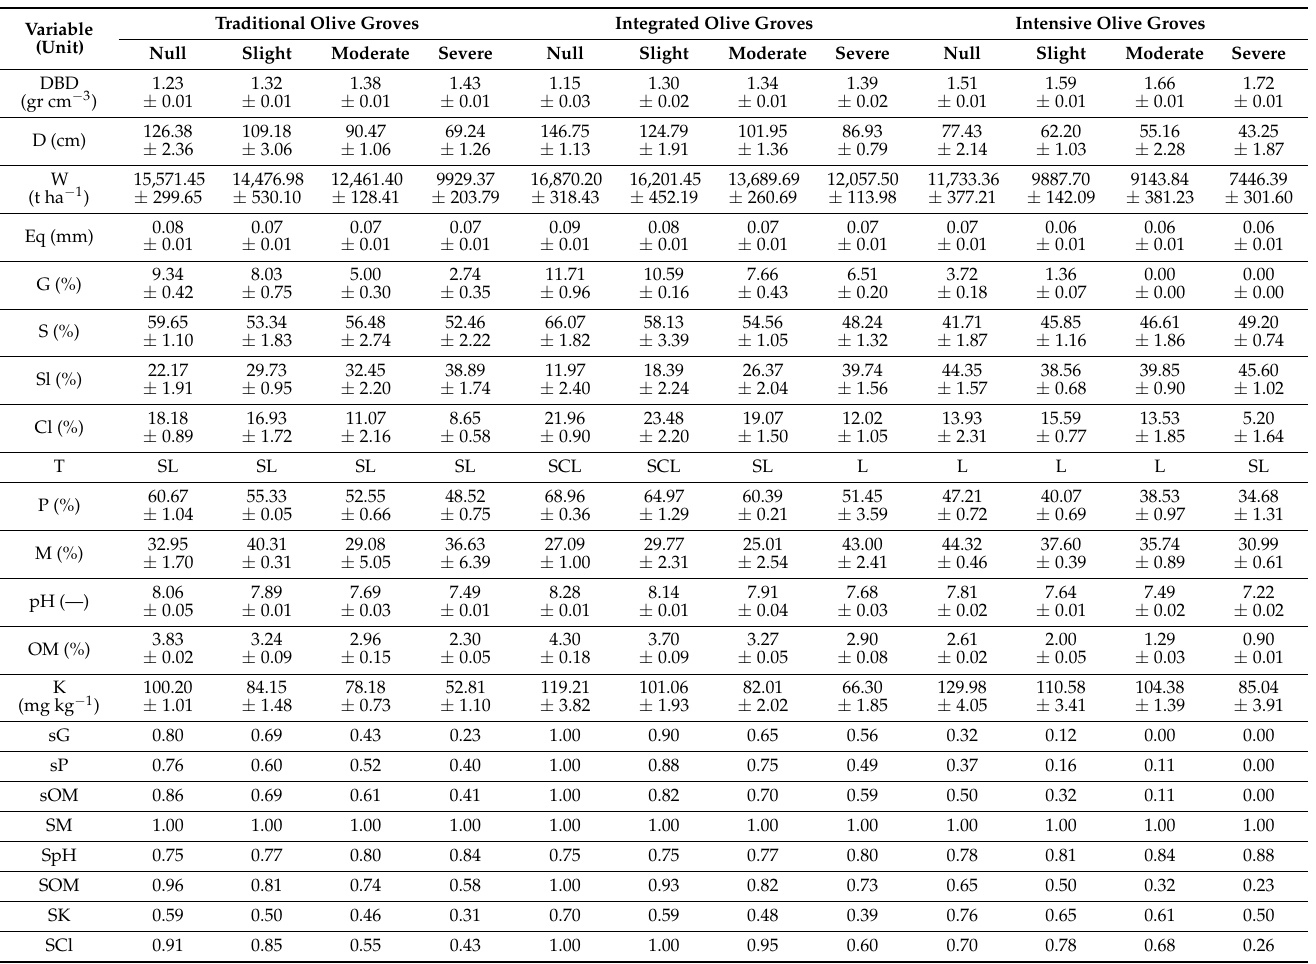
values of 20.03%, 25.39%, and 26.54%, respectively, for traditional, integrated, and intensive olive groves, with the latter presenting the lowest values. Table 3. Mean and standard error (x ± SE) values for each of the edaphic variables analysed (DBD: dry bulk density; D: soil depth; W: soil weight; Eq: equivalence 1 t soil; G: gravel; S: sands; Sl: silts; Cl: clays; T: texture, where L: loam, SL: sandy-loam, SCL: sandy-clay-loam; P: porosity; M: moisture; OM: organic matter; K: potassium). Their units are specified according to the different management options (i.e., traditional, integrated, and intensive) and degrees of erosion (i.e., null, slight, moderate, and severe) defined for the olive grove in the study area. The standardised values for gravels, porosity, and organic matter (sG, sP, sOM), and the sufficiency values for moisture, pH, organic matter, potassium, and clays (i.e., SM, SpH, SOM, SK, SCl), used for the estimation of different agronomic indices, are also